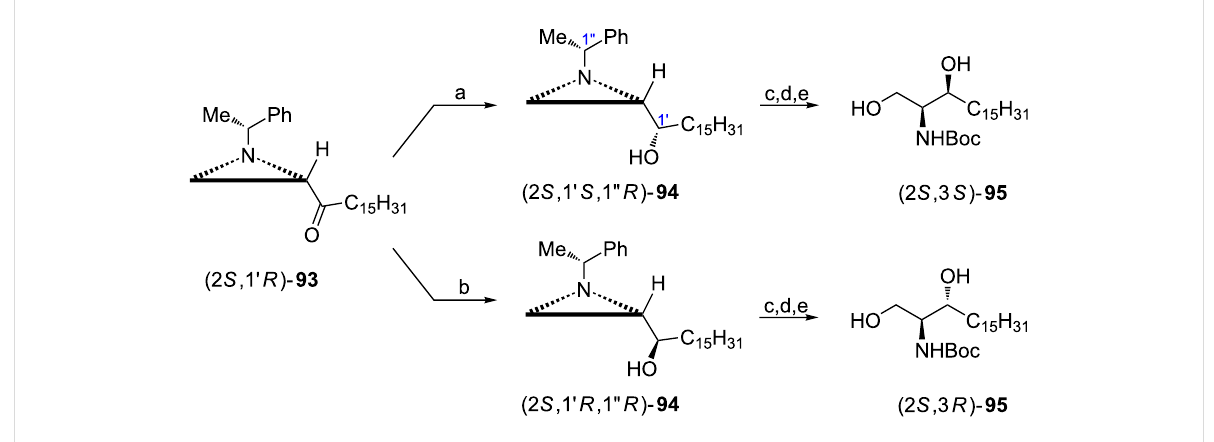
Scheme 24: Synthesis of N -Boc-safingol ((2 S ,3 S )- 95 ) and N -Boc- ᴅ - erythro -sphinganine ((2 S ,3 R )- 95 ). Reagents and conditions: a) ʟ -Selectride ® , THF, − 70 °C, 0.5 h; b) NaBH 4 , ZnCl 2 , MeOH, − 30 °C, 0.5 h; c) AcOH, CH 2 Cl 2 , rt, 14 h; d) KOH, EtOH, rt, 3 h; e) H 2 , Pd(OH) 2 /C, Boc 2 O, MeOH,